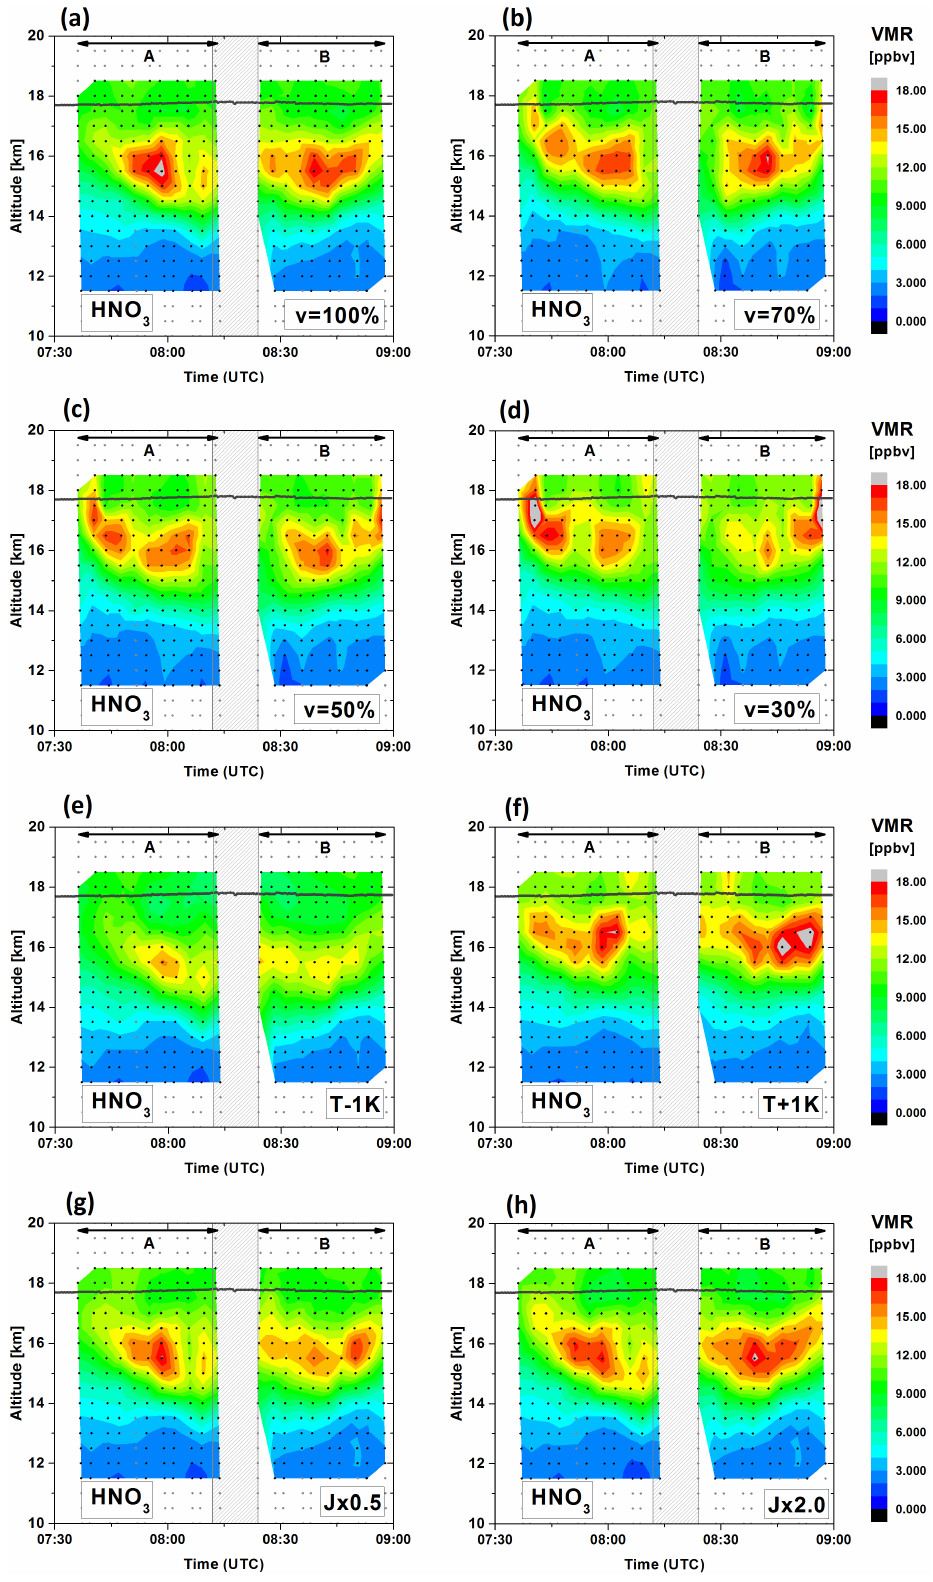
Figure 11. Same as Fig. 9 but for the flight on 30 January 2010 under conditions free of